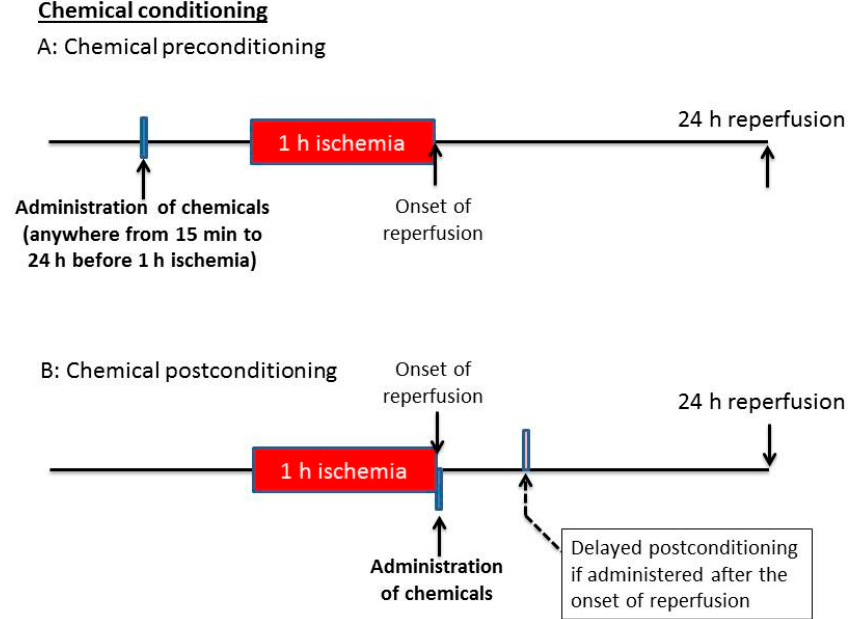
Figure 3. Representative scheme of chemical conditioning. The administration of the chemical agent or pharmacological drugs can be given either before ( A ) or after ( B ) lethal ischemic stroke. If the chemical is given during the reperfusion process instead of at the onset of reperfusion, delayed postconditioning effects would be induced